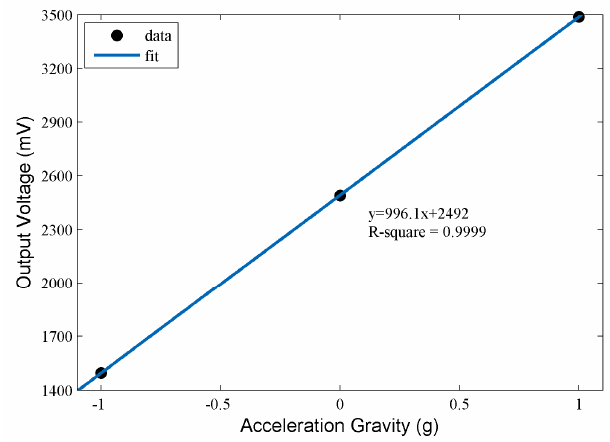
Figure 6. Relationship between output voltage and acceleration value.